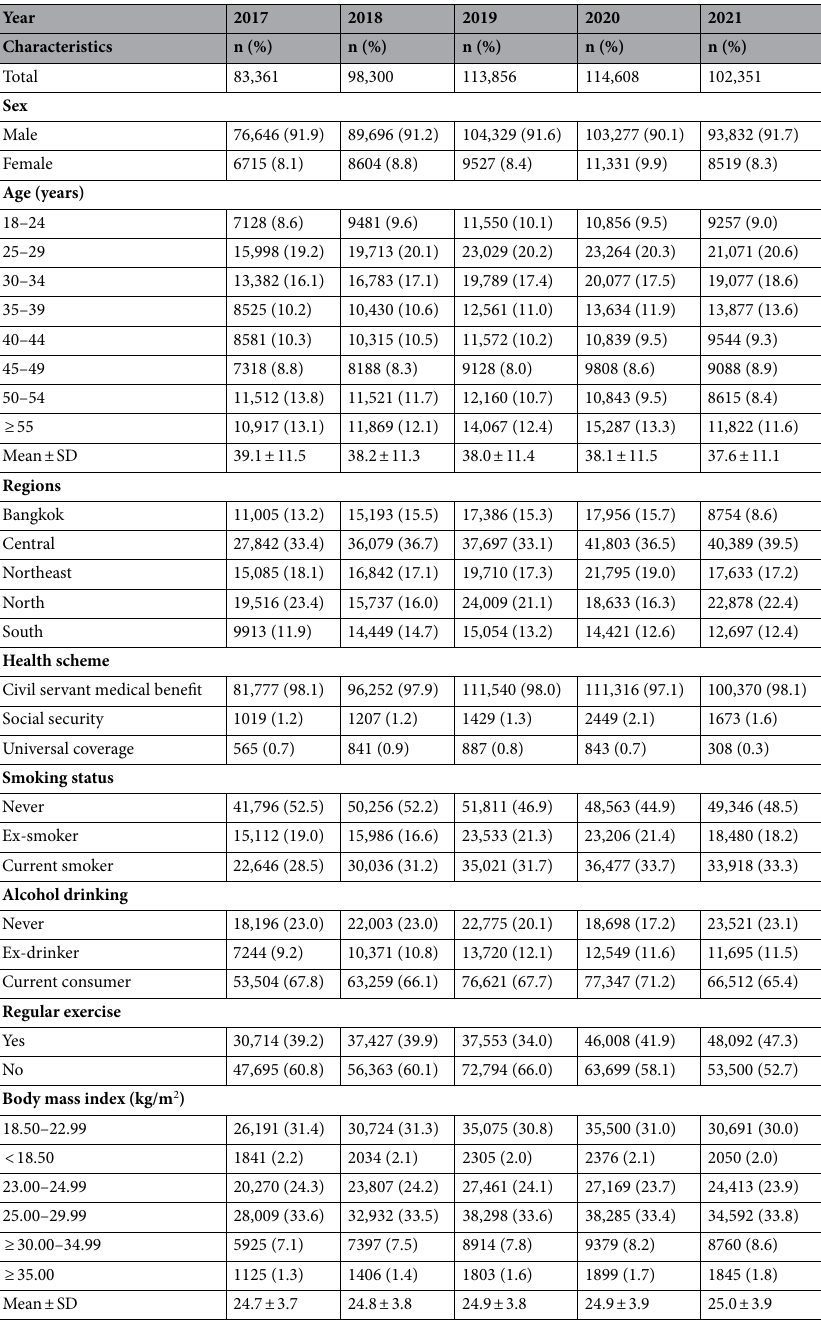
Table 1. Demographic characteristic of participants from 2017 to 2021(N = 512,476). SD standard